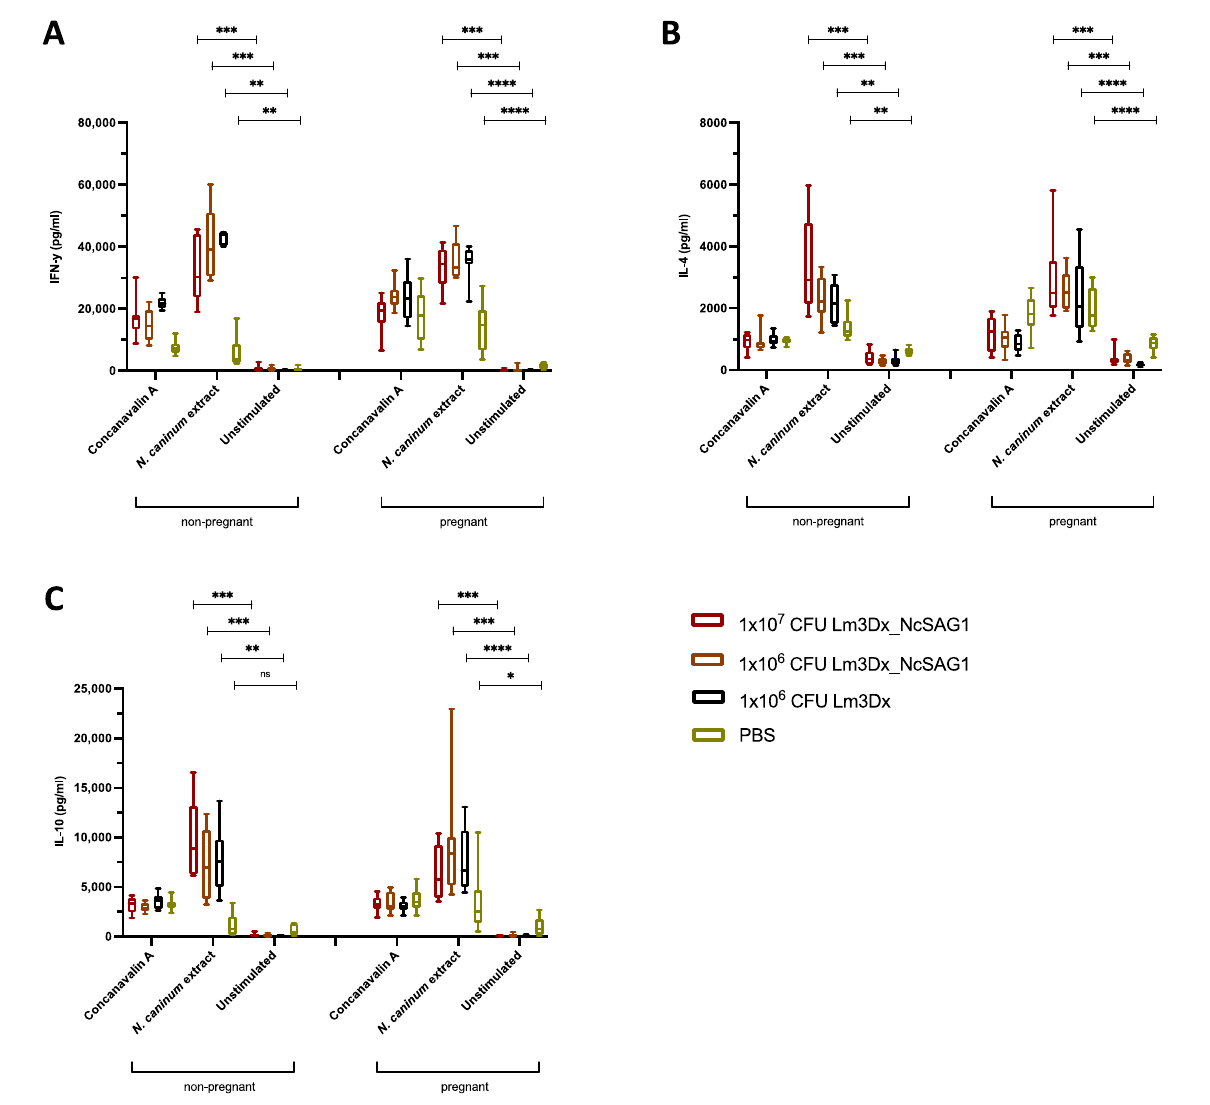
Figure 5. Cytokine measurements after splenocyte re ‐ stimulation. Splenocytes were isolated at the endpoint (38–40 days post challenge) from non ‐ pregnant mice and dams. After isolation, splenocytes were cultured and stimulated for 3 days with either ConA, soluble N. caninum extract or remained unstimulated. Results are shown as box plots. ( A ) A strong IFN ‐ γ response was measured in non ‐ pregnant and pregnant mice that were immunized with either Lm3Dx_NcSAG1 or Lm3Dx (empty vector) but not with PBS. ( B ) High levels of IL ‐ 4 were observed in mice inoculated with 1 × 10 7 CFU Lm3Dx_NcSAG1. Decreased IL ‐ 4 levels were obtained in mice vaccinated with 1 × 10 6 CFU Lm3Dx_NcSAG1 and with 1 × 10 6 CFU Lm3Dx. ( C ) Additionally, high levels of IL ‐ 10 were measured after splenocyte re ‐ stimulation with N. caninum extract in non ‐ pregnant mice and dams. **** p < 0.0001 , *** p < 0.0002 , ** p < 0.0022 , * p < 0.0172 , ns = not significant (Mann– Whitney ‐ U test).